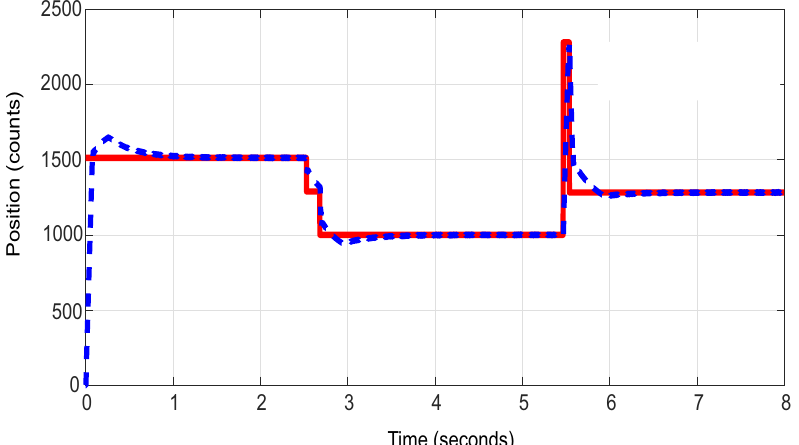
Figure 10. Tracking test with different reference positions of servo motor: tuned system response with proposed method and reference